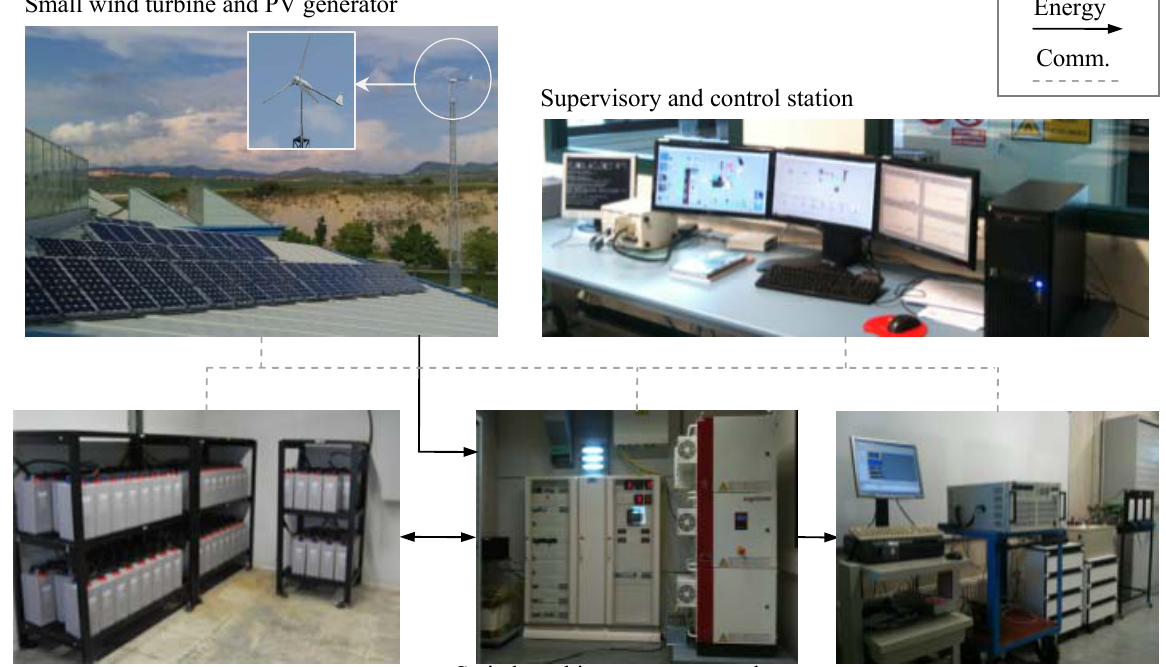
Figure 21. Microgrid installed at Public University of Navarre